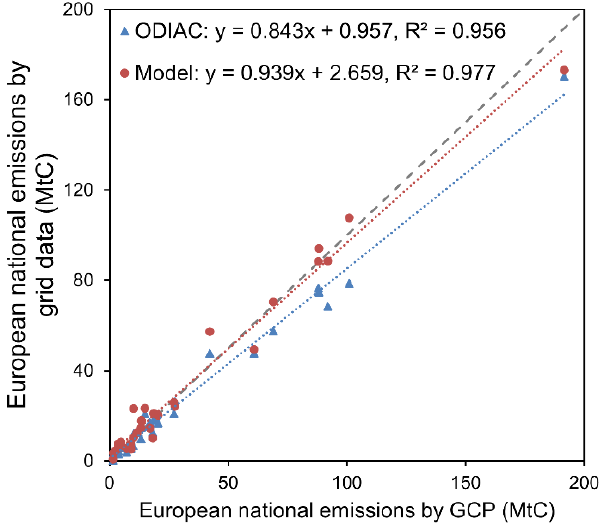
Figure 11. The correlation between emissions of European countries by GCP results and two grid data: the orange circles indicate the results of the GCP and model estimates and the blue triangles indicate the results of the GCP and the ODIAC data.